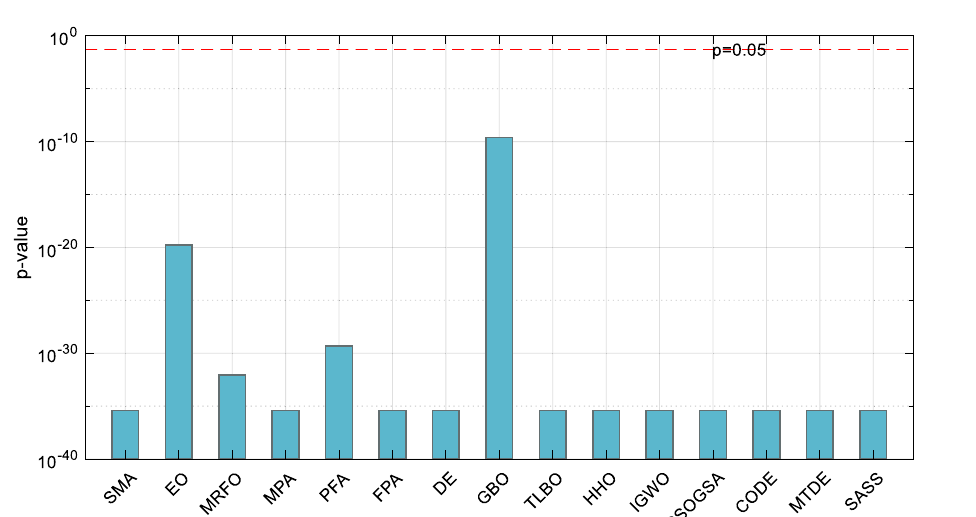
Figure 11. Wilcoxon rank-sum test results of randomly selected position points.